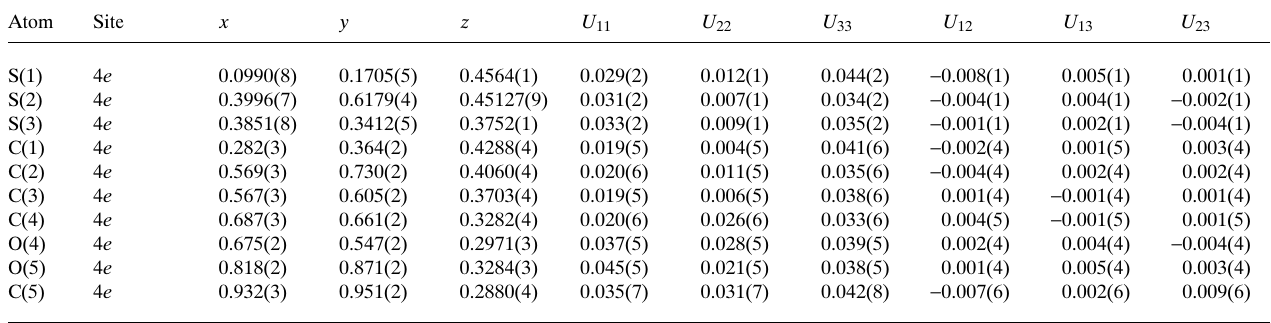
Table 3. Atomic coordinates and displacement parameters (in Å 2 )